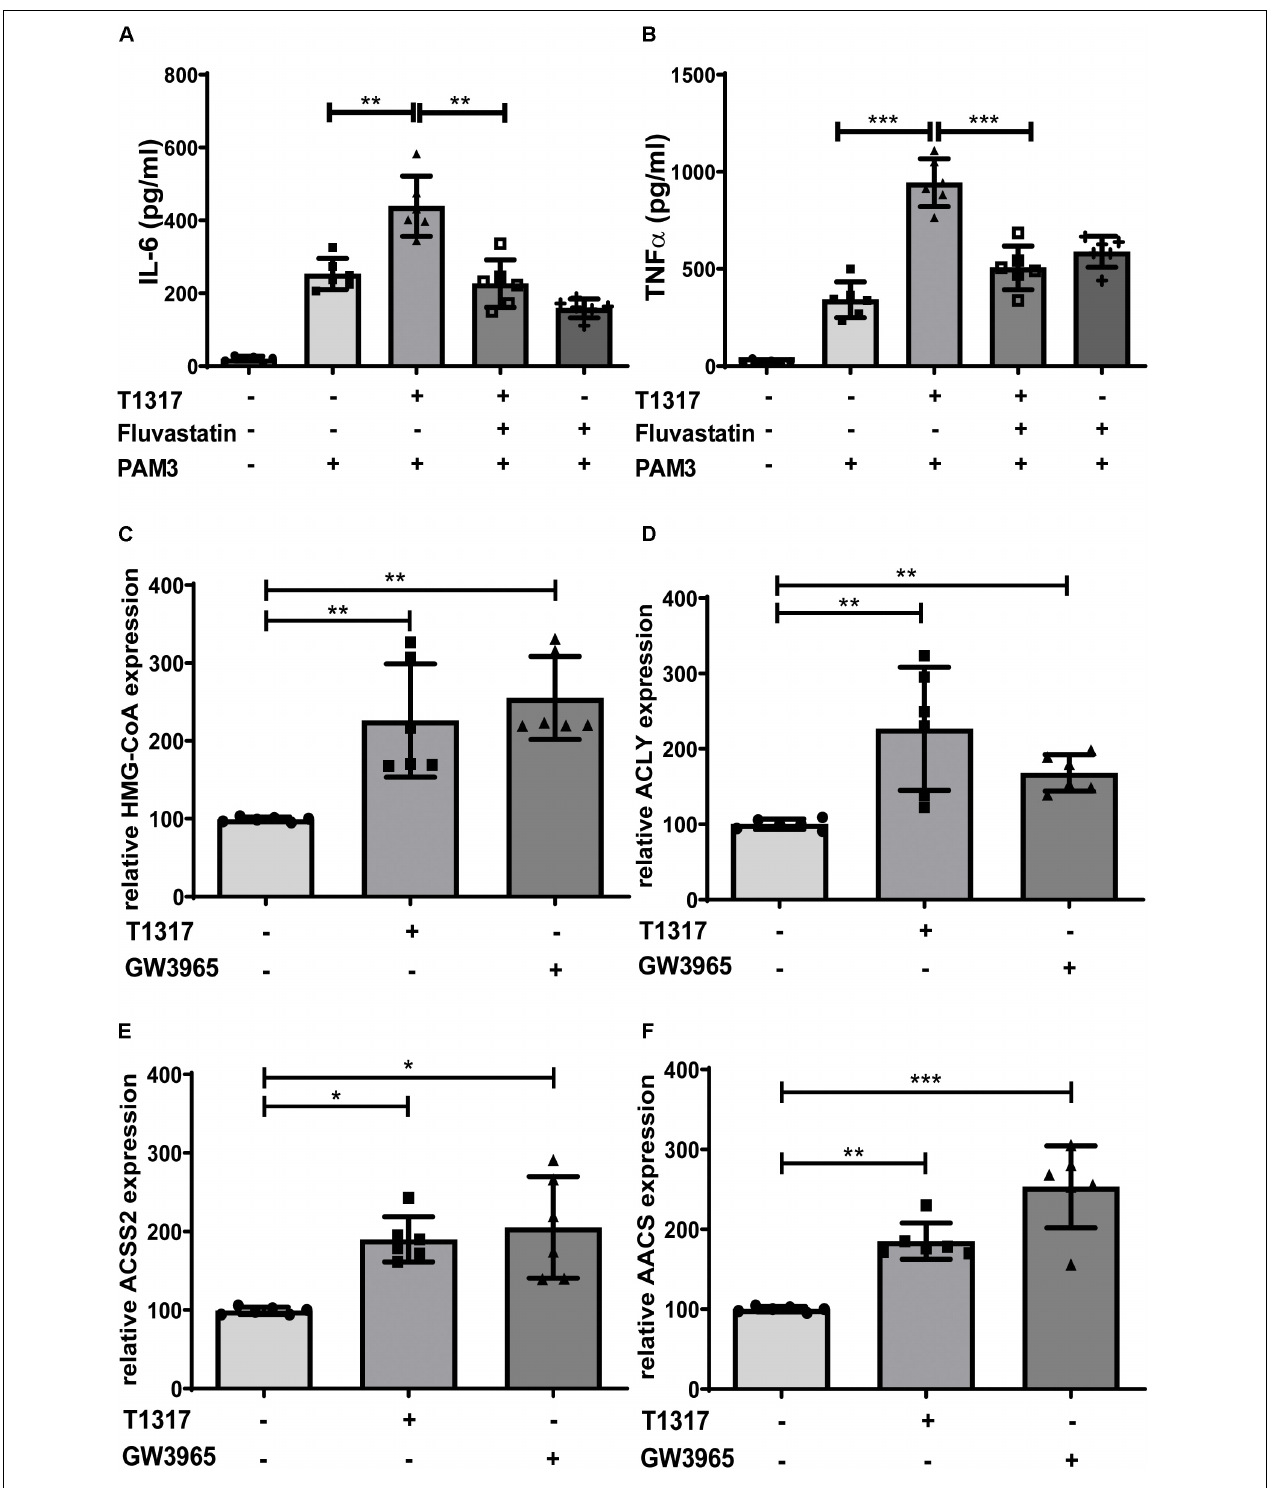
FIGURE 4 | LXR priming depends on the mevalonate pathway. Monocytes were treated as indicated with 2 µ M T1317 (LXR agonist), 10 µ M GW3965 (LXR agonist), 20 µ M Fluvastatin (HMG-CoA reductase inhibitor) or vehicle for 24 h and kept for 5 days in complete medium. (A,B) Cells were restimulated with 5 µ g/ml Pam3cys for 24 h and IL-6 (A) and TNF α (B) were measured in the supernatant. (C–F) mRNA levels were analyzed by real-time qPCR 24 h after priming. Graphs represent mean values ± SD of six individuals in three different experiments. * P < 0.05, ** P < 0.01, and *** P < 0.001.